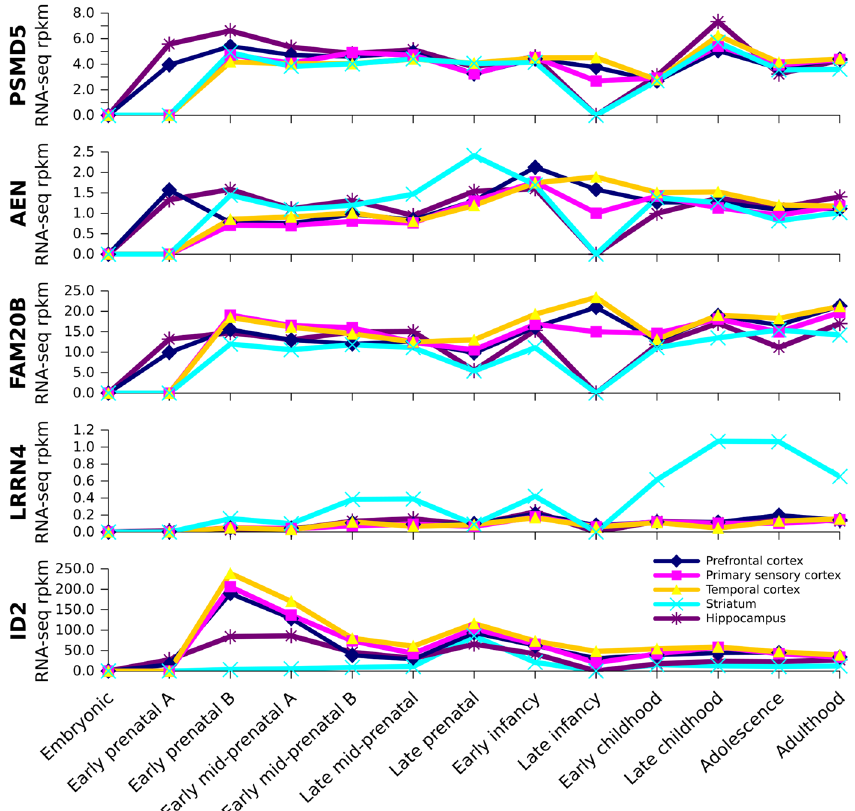
Fig. 4 Expression of identi fi ed genes in brain at different stages of human development. Brainspan RNA-seq developmental transcriptome data showing developmental pro fi les of PSMD5 , AEN , FAM20B , LRRN4 , and ID2 , the genes found to be similarly methylated in patient-derived iPS cells, ONS cells, and fi broblasts compared to control-derived cells. The x-axis shows the developmental stages (de fi ned by Brainspan, see Methods). The y-axis shows the level of expression in each region at each developmental stage in RPKM (reads per kilobase of exon per million mapped